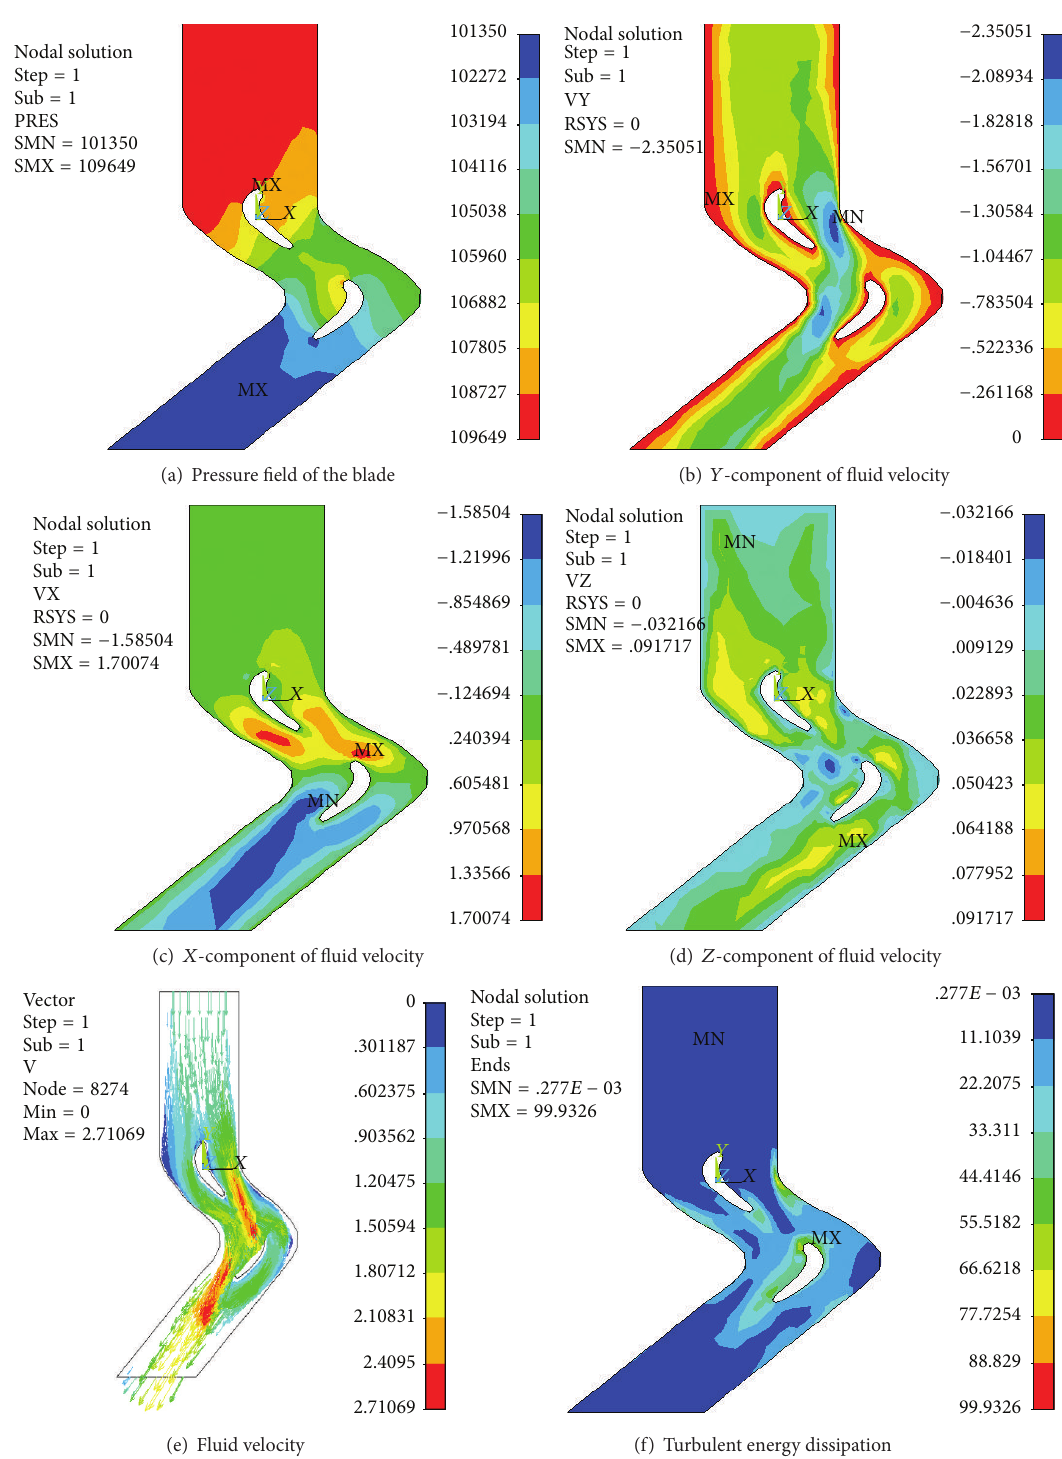
Figure 10: The flow field of I-type